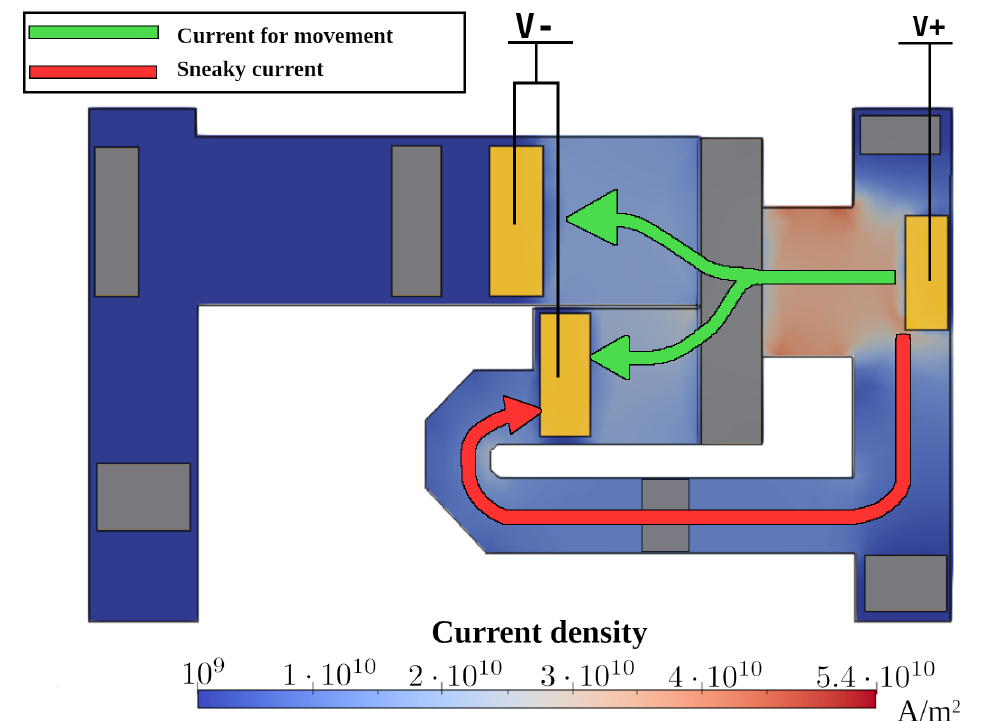
Figure 9. Current paths during duplication operation. The color gradient indicates the current density inside the cell. In green the current path needed to move the skyrmion. In red the additional path generated. The current flowing in this path is not needed for current operation and increase the power consumption in the